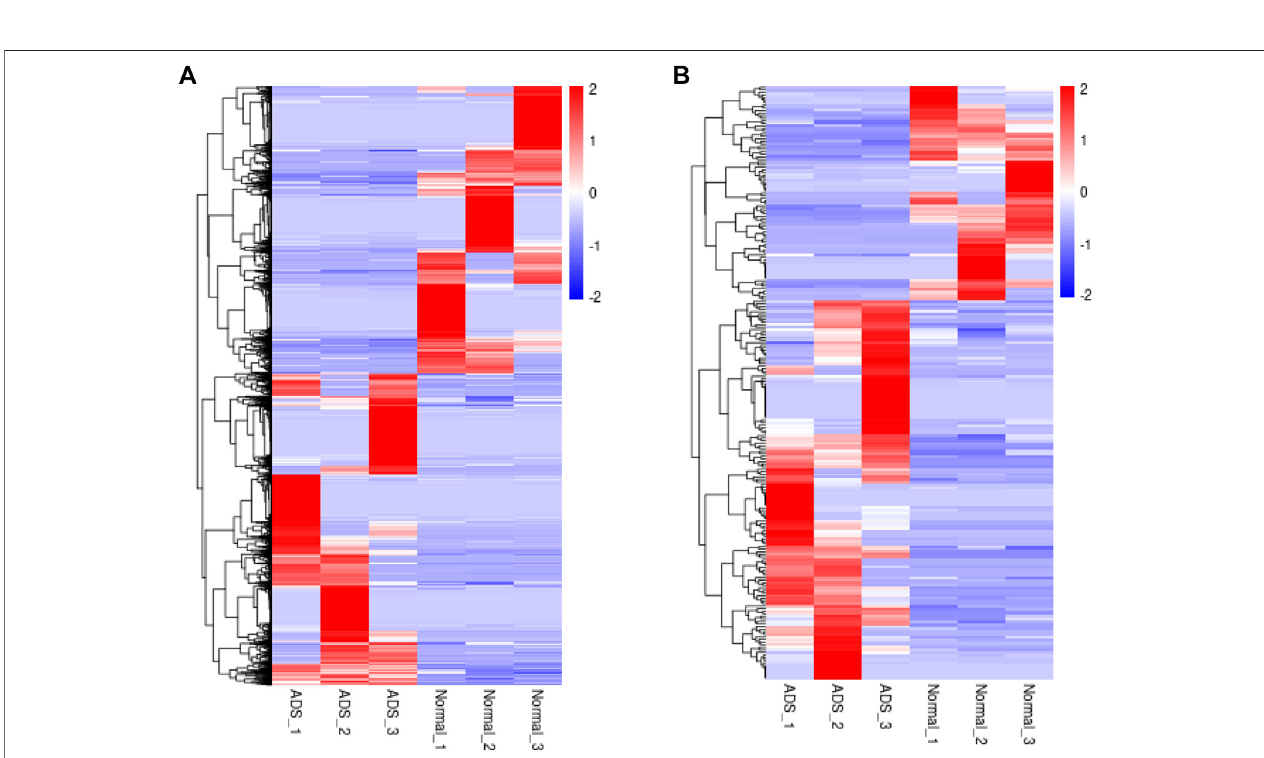
FIGURE 4 | Clustering analysis. Hierarchical clustering illustrates distinguished expression difference of (A) mRNAs and (B) lncRNAs between the two groups and homogeneity between groups.